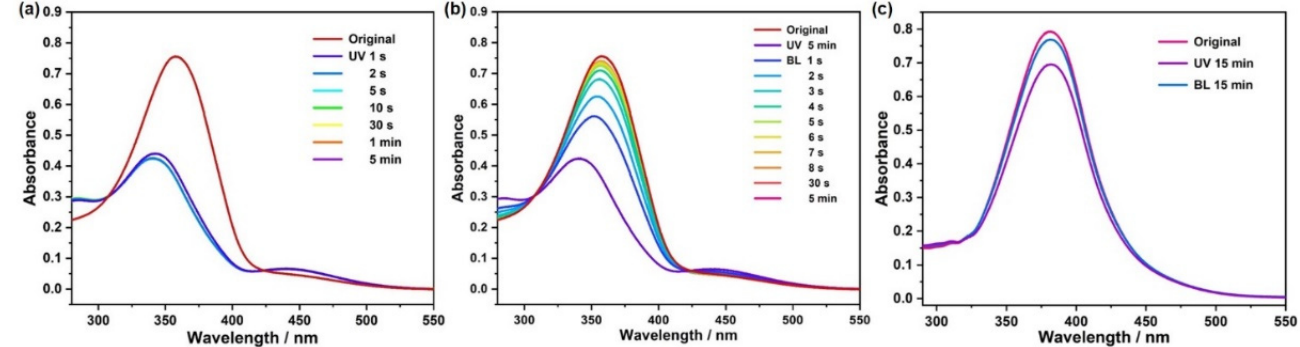
Figure 4. Time-resolved UV–Vis absorption spectra upon ( a ) 365 nm UV irradiation for Abtz; ( b ) continuous 450 nm blue-light irradiation for Abtz; ( c ) 365 nm UV irradiation and 450 nm blue-light irradiation for 1 in ethyl acetate solution.